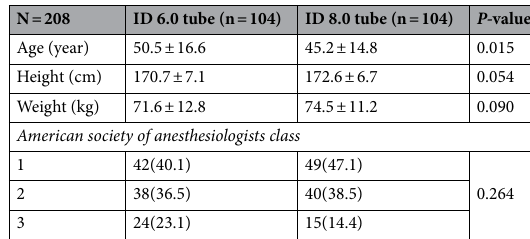
Table 1. Patient demographics. Values are presented as mean ± SD or number (proportion). ID internal diameter.